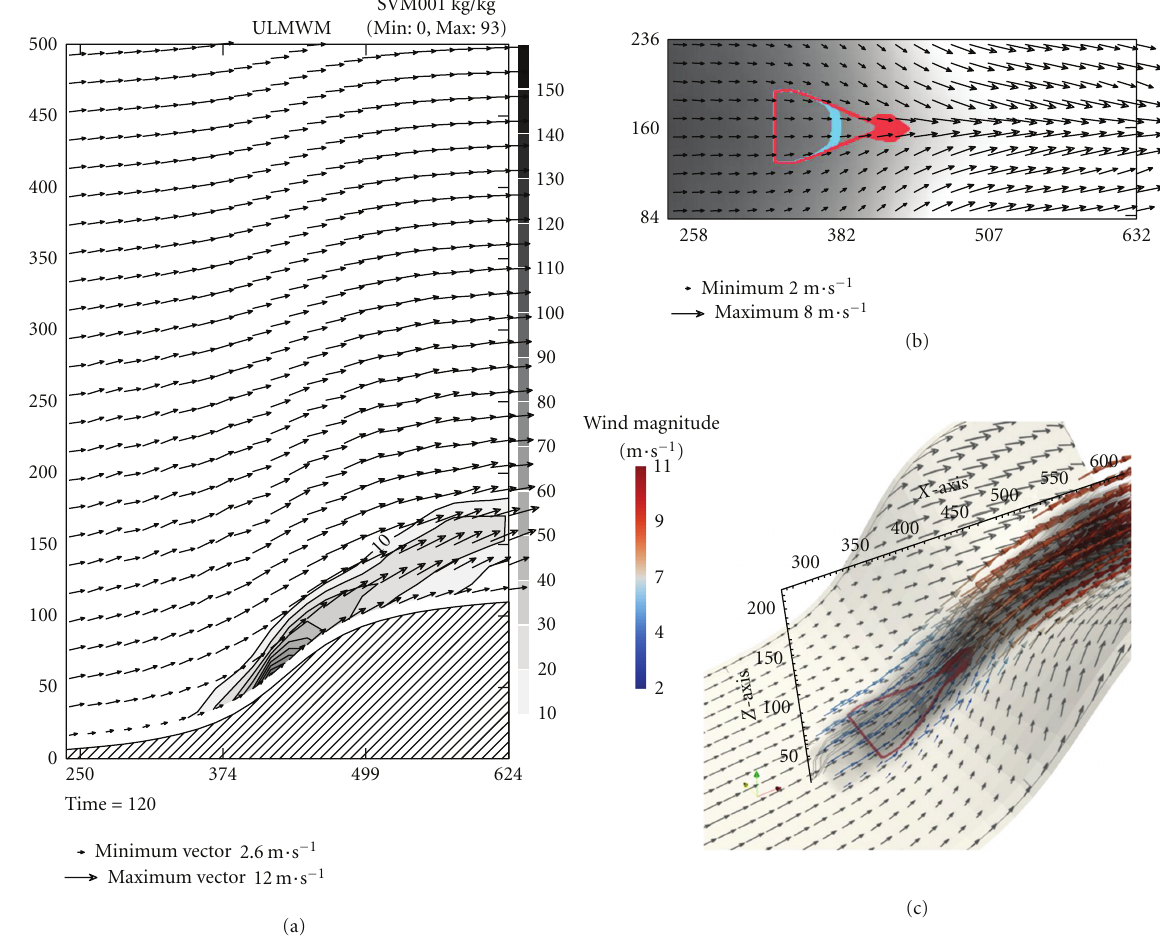
Figure 7: UPCAN (a) Horizontal section ( x/y ) at Z = 10m, fire lines after 120 seconds for the coupled (red) and noncoupled (grey) simulations. Arrows denote the wind vectors at ground level for the coupledcase. (b) Cross-section ( x/z ) of the coupled case at Y = 160 m, shading represents concentration of the injected passive